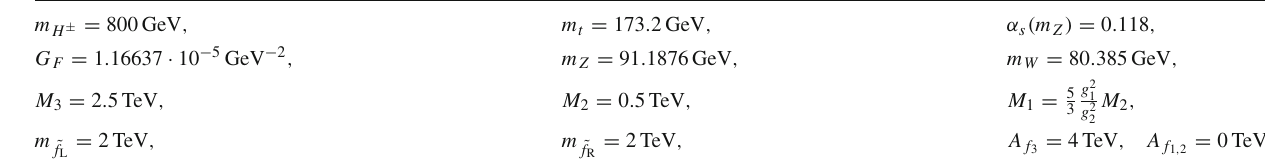
trilinear soft-breaking terms for the sfermions A f index g = 1 , 2 , 3. The charged Higgs mass m H ± is fixed to the shown value, if not mentioned